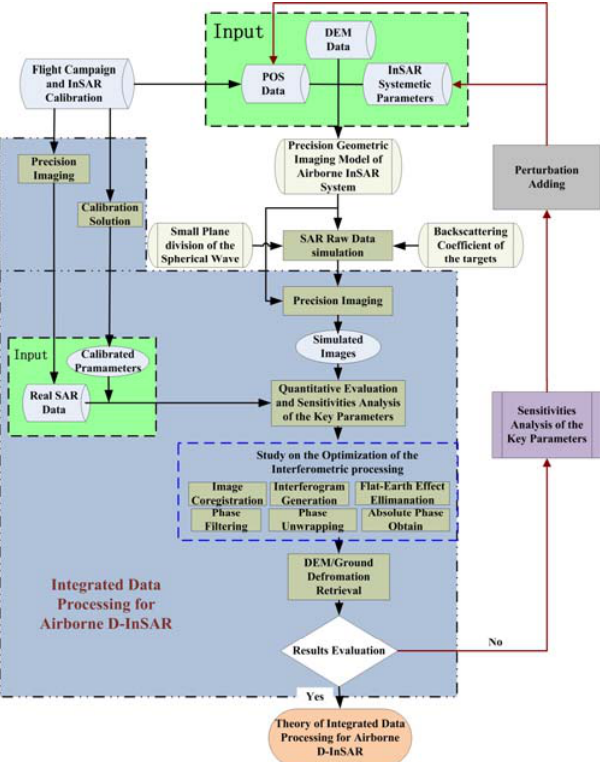
Fig. 1. Overall research scheme of airborne D-InSAR data integrated processing based on semi-physical simulation